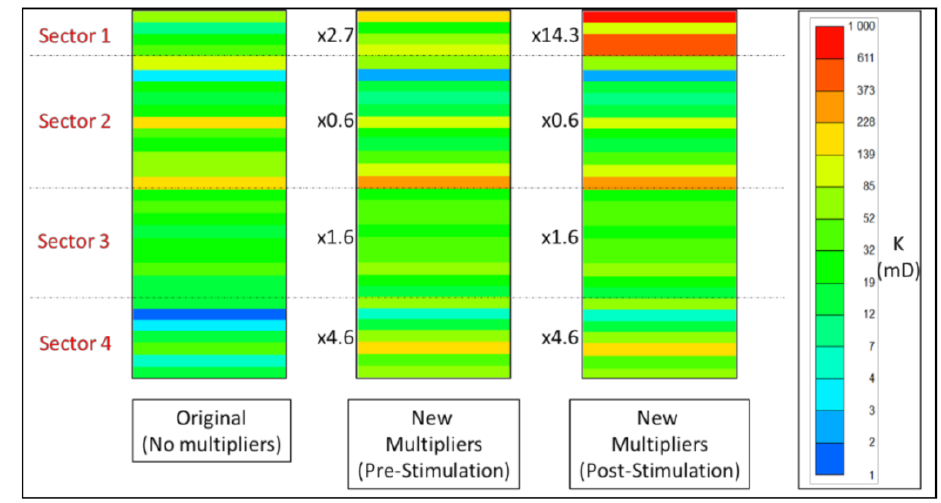
Figure 9. Permeability multipliers applied to match PLT logs pre- and post- acid stimulation